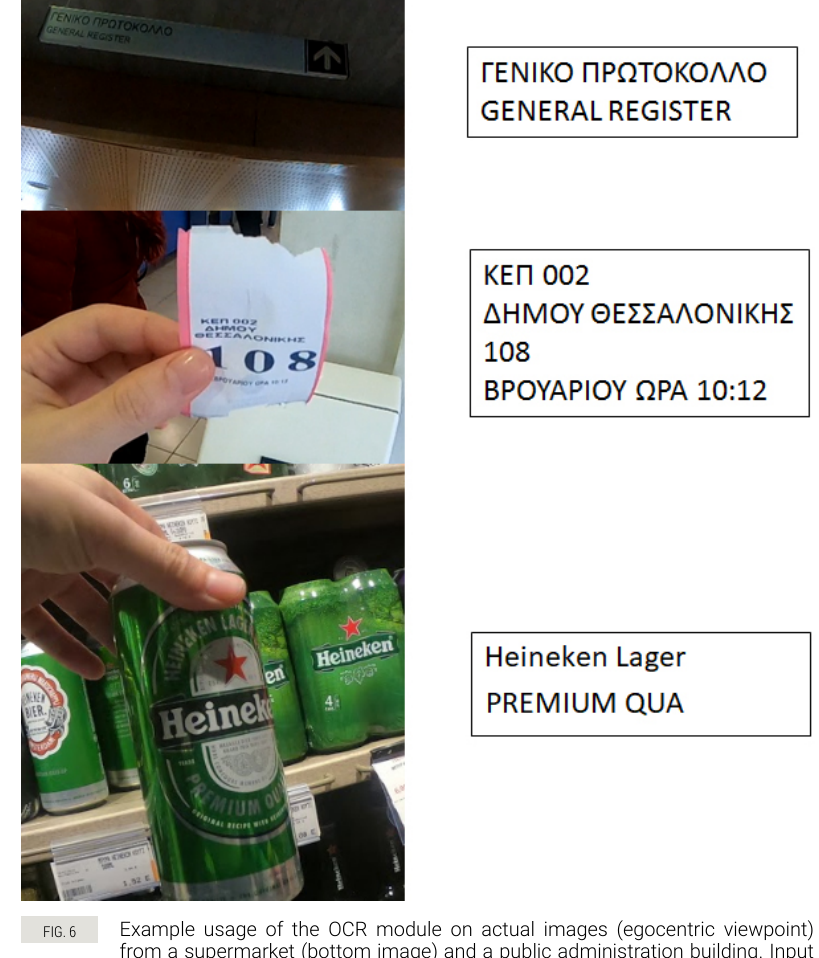
Example usage of the OCR module on actual images (egocentric viewpoint) from a supermarket (bottom image) and a public administration building. Input images on the left and the identified text on the right (mostly Greek